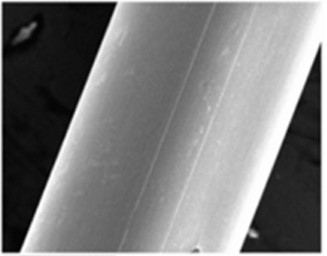
Figure 13. Longitudinal welding cord: hypotube #8(ref) (scale = 200 µ m).